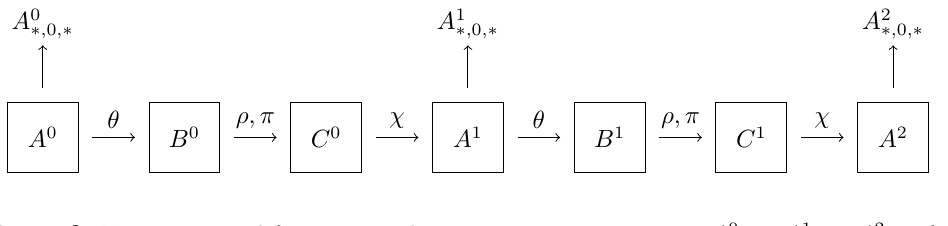
Figure 3: Notations used for our attack on 3 consecutive outputs A 0 Ketje Jr v1 and a rate of 40